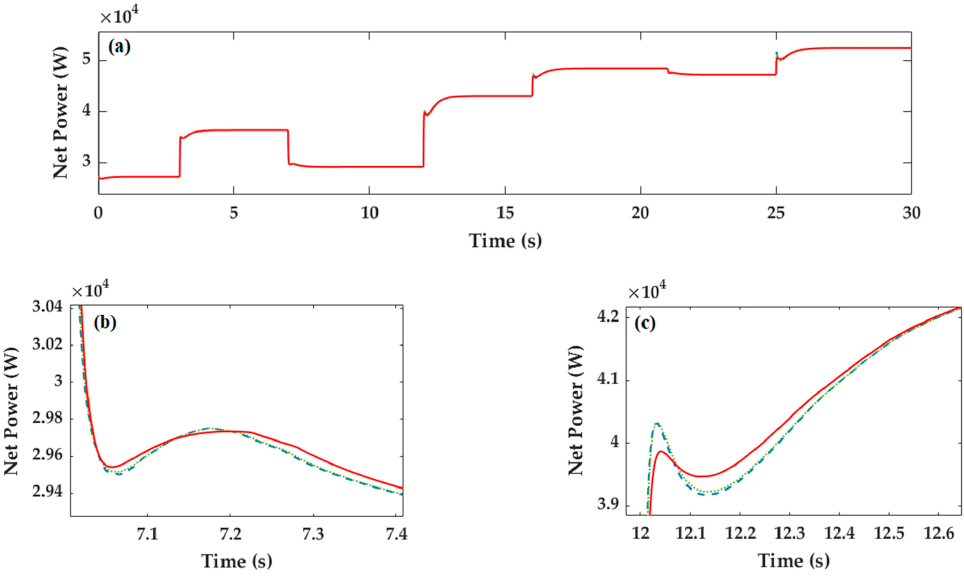
Figure 14. PEMEC parameters: ( a ) 30 s of net power; ( b ) net power at 7 s; ( c ) net power at 12 s.